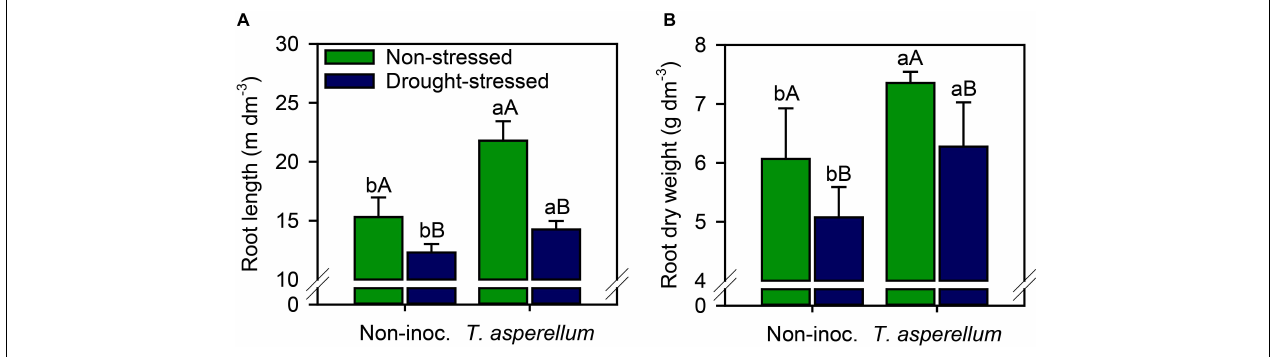
FIGURE 7 | Root length (A) and root dry weight (B) of sugarcane plants according to the treatments. Different lowercase letters indicate significant differences between presence and absence of moderate drought stress, and different capital letters indicate significant differences between presence and absence of inoculation with T. asperellum by Fisher’s protected LSD test at p ≤ 0.05. Error bars express the standard error of the mean ( n =